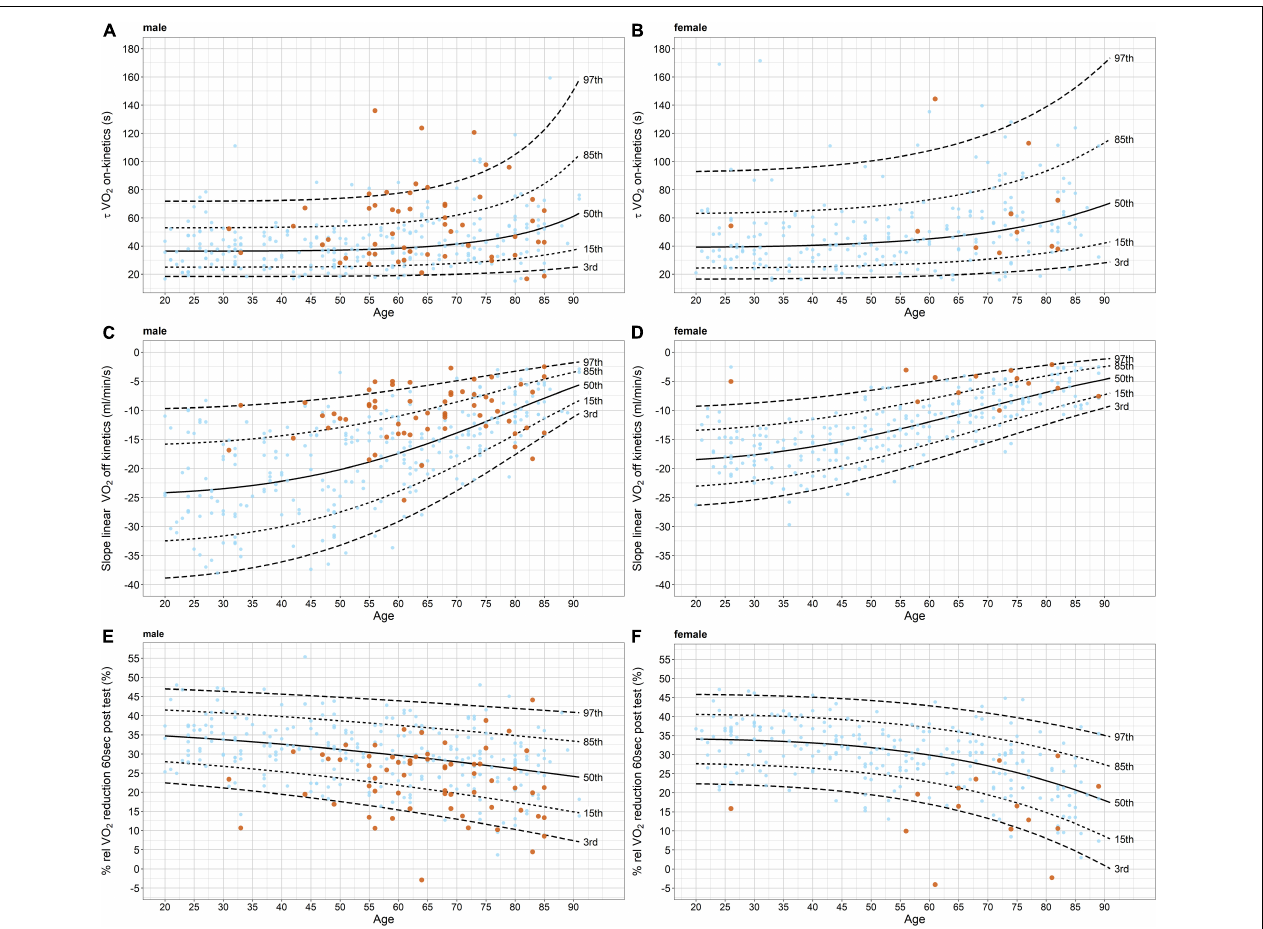
FIGURE 3 | Quantile curves for τ VO 2 on-kinetics, slope linear VO 2 off-kinetics (ml/min/s) , and % rel VO 2 reduction 60 s post-test for males and females, separately. The quantile curves are based on the healthy participants only (light blue data points). Values of the patients with heart failure are presented in orange. ˙VO 2 , oxygen